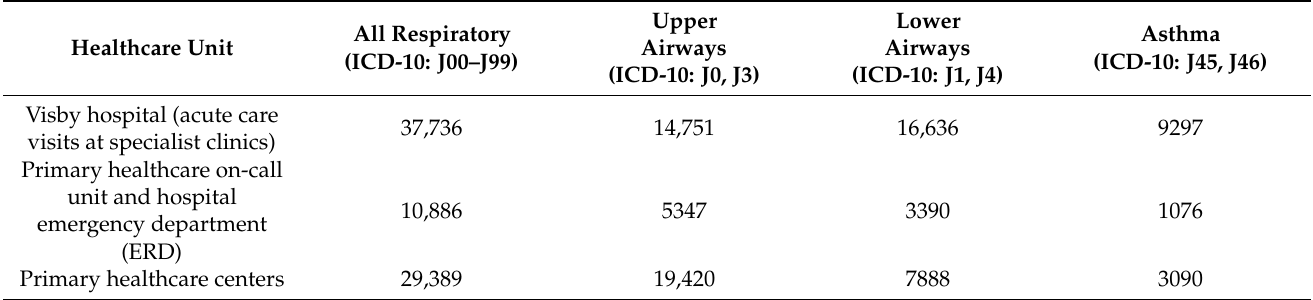
Table 1. The numbers of respiratory diagnoses at different healthcare units in Visby during the period of